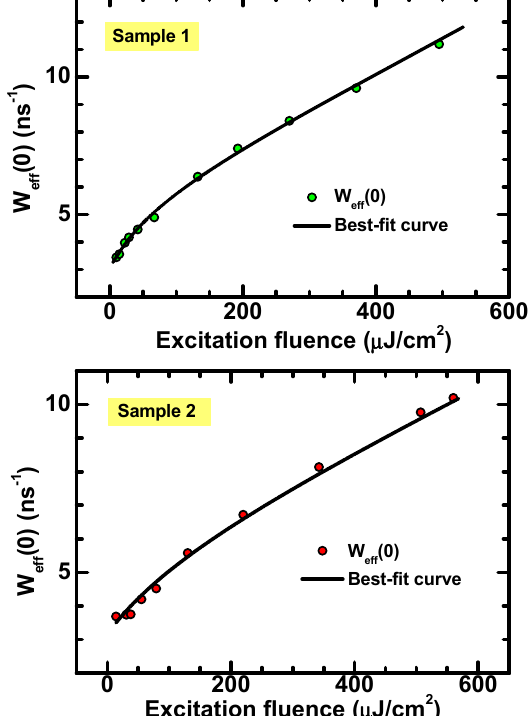
Figure 5. Instantaneous recombination rate calculated at t = 0 vs. excitation fluence. The black curves are the best fit of the data obtained by use of Equation (8). Table 1. Recombination parameters and equilibrium free carrier density extracted by the data analysis.